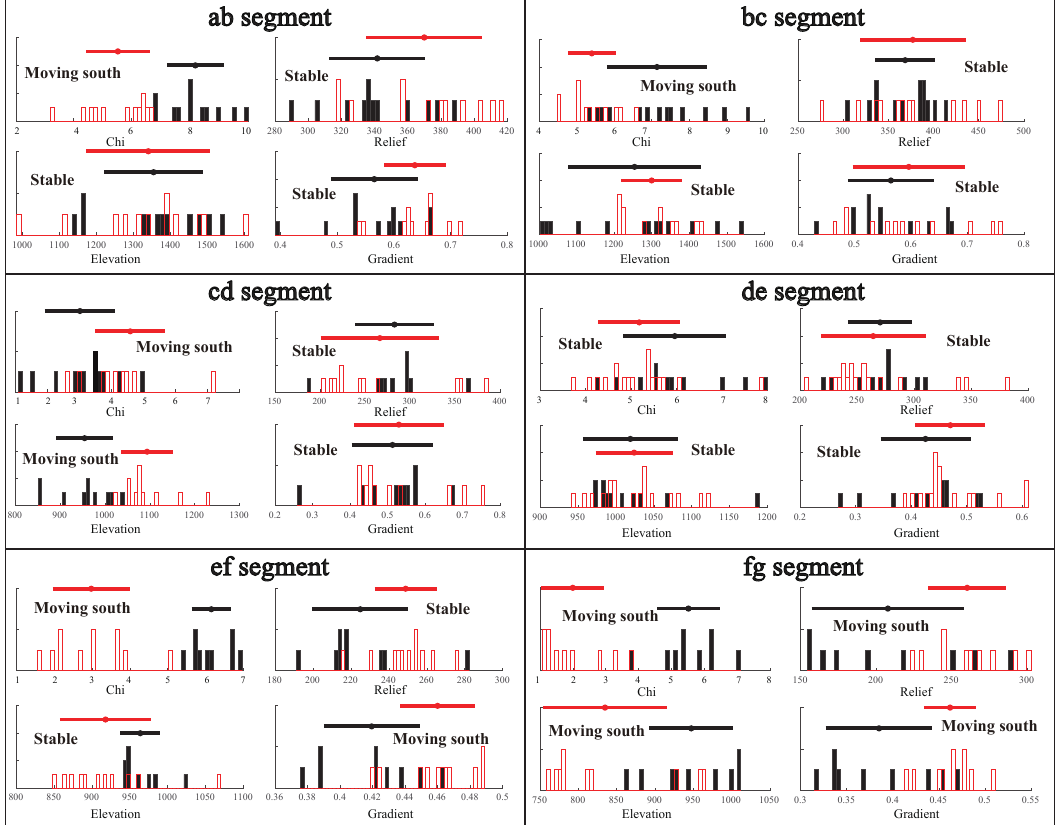
Figure 5. Divide metrics (Gilbert metrics and χ ) histograms for the ab segment, bc segment, cd segment, the de segment, the ef segment, and the fg segment. Histograms with red rectangles represent watersheds on north range, and histograms with black fillings mean watershed from south flank. Note that the ab, bc, cd, and de segments indicate that the current main divide is stable, while the ef and fg segments show that the divide is moving to south. It should be noted that all the calculations on the Gilbert metrics and χ were determined with a base level of 700 m. The results are calculated by the DivideTools [14] based on TopoToolbox [56].